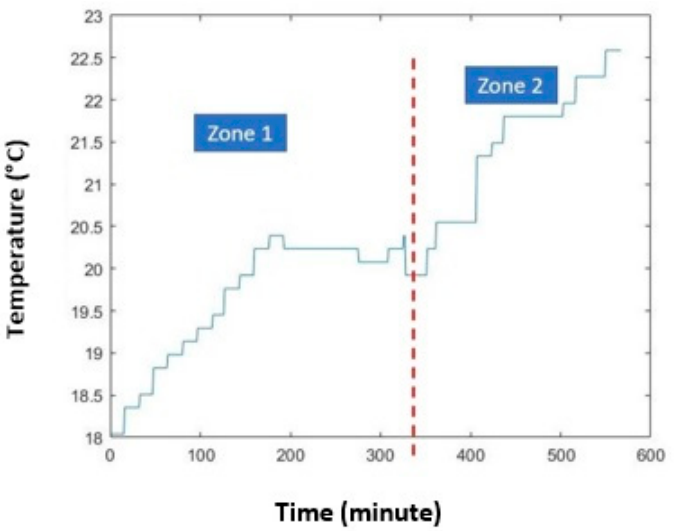
Figure 23. Indoor temperature changes in the practical classroom (measured values). Zone: It remarks different conditions during the experiments.